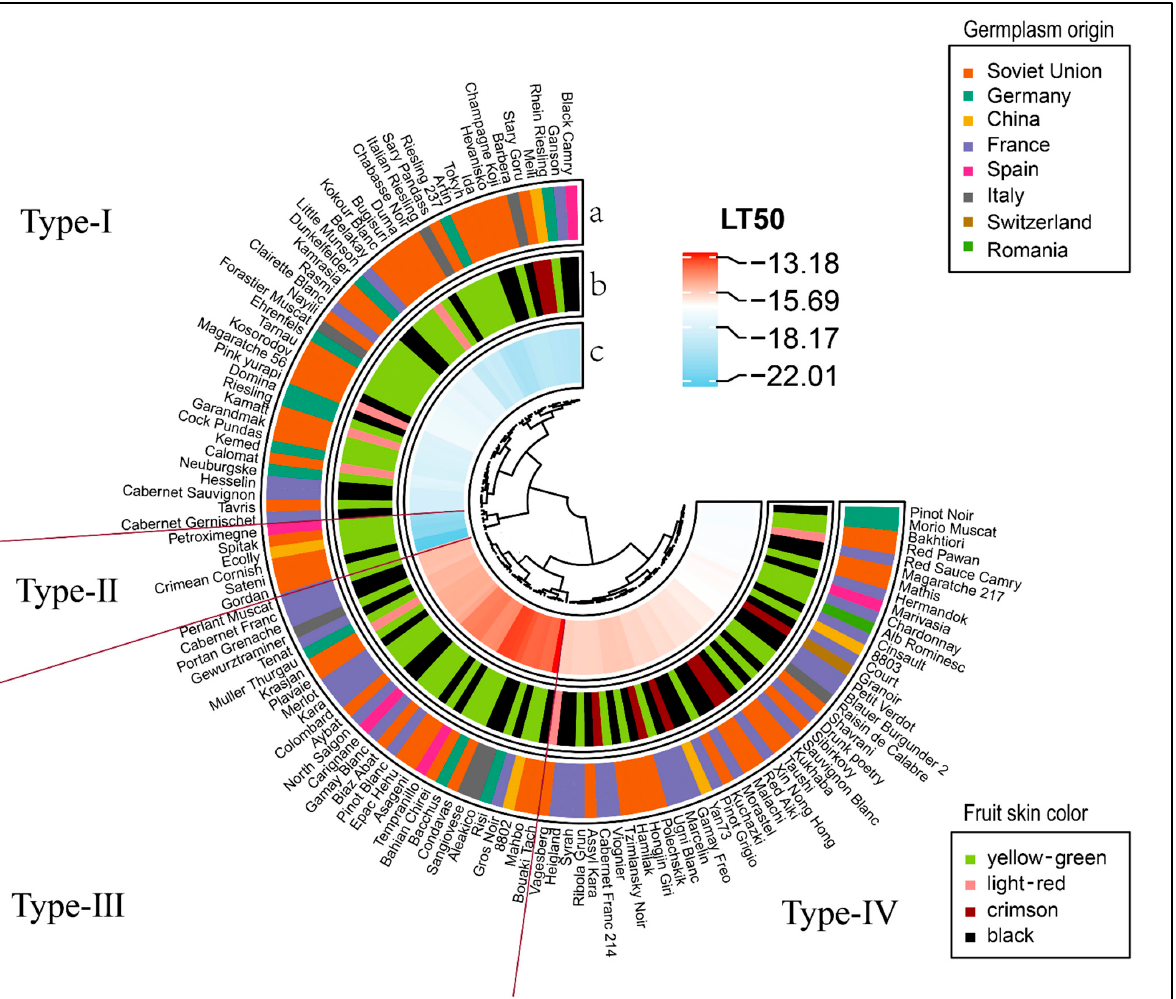
Figure 2. Clustering results of cold hardiness identification in 124 germplasms. Layer a corresponds to germplasm origin information, layer b corresponds to germplasm fruit skin color information, and layer c corresponds to LT 50 value. In the information of fruit skin color, color is qualitative rather than quantitative to some extent. Wine grape fruit skin color is mainly defined according to the type of wine. According to the color of the wine can be roughly divided into yellow ‐ green, light ‐ red, crimson, and black, corresponding to white wine, rose wine, red wine, and toning or purplish wine.